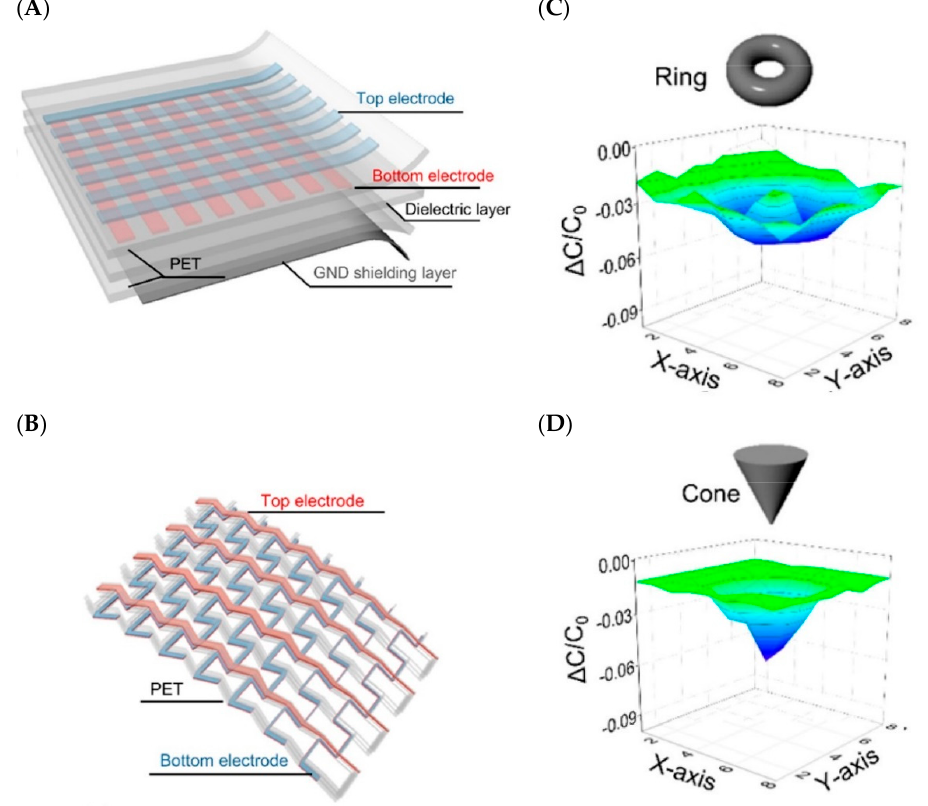
Figure 8. ( A ) Graphene-based flexible capacitive sensor, ( B ) The mesh-like internal structure shows the top electrode as red and bottom as blue, ( C ) Detection of Ring shape, ( D ) Detection of Cone shape [157].